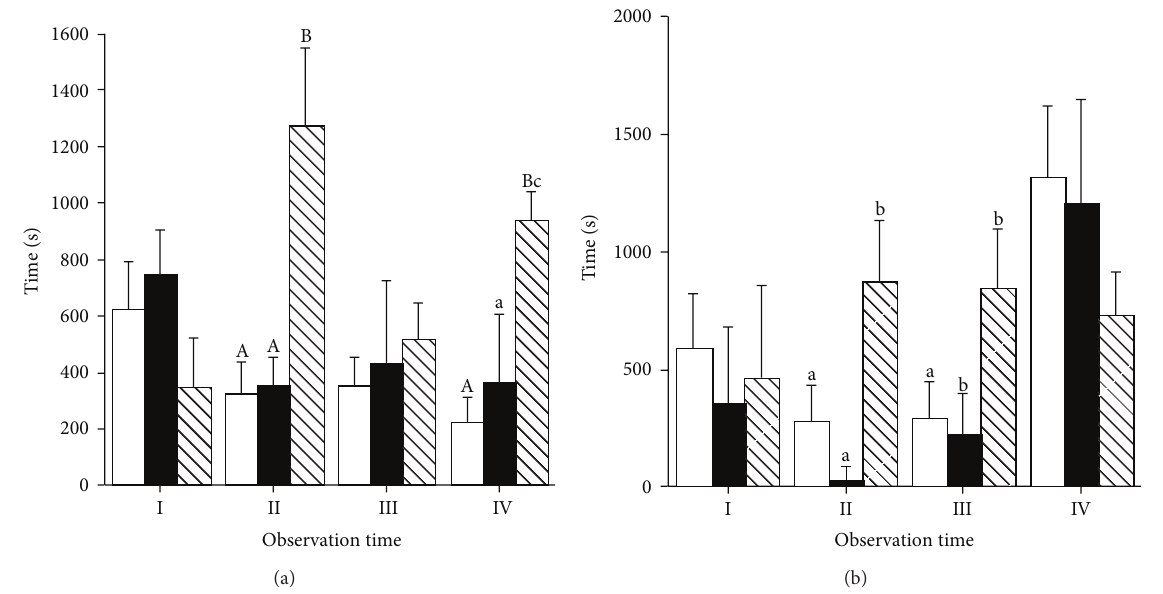
Figure 2: Effect of different types of physical exercise (race blank; maximal exercise shaded; daily exercise lined) on standing up activity (a) and resting behaviour (b) of Standardbred horses housed in single stalls. Mares were examined at rest in their stalls (Time I), immediately after exercise (Time II), one (Time III), and two hours (Time V) after the completion of exercise. Values are expressed as means ± SE. For parameters where a significant effect of type of exercise × time interaction was noted, means with different capital and low letters indicate significant difference ( 𝑃 < 0.01 and 𝑃 < 0.05 , resp.) between types of exercises.